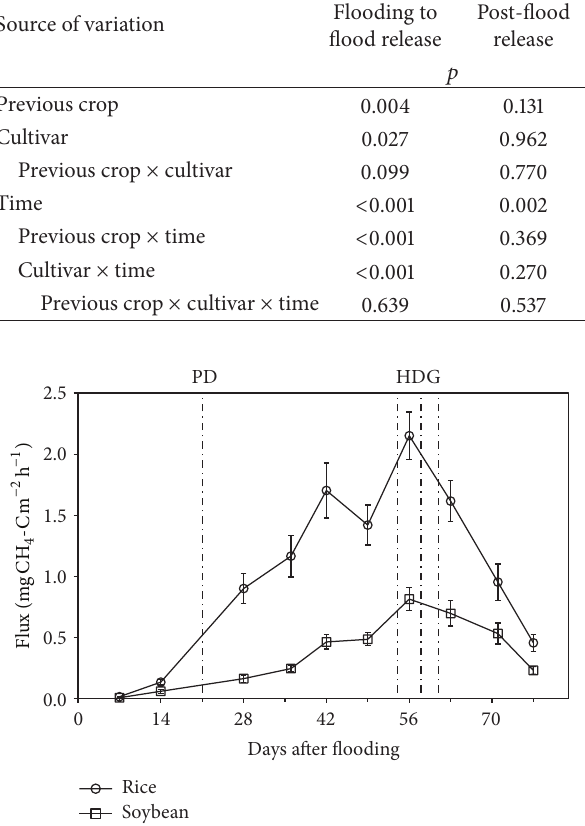
Figure 1: Methane fluxes over time throughout the flooded portion of the 2013 growing season from previous crop treatments averaged across cultivar at the Northeast Research and Extension Center in Keiser, Arkansas. The vertical dashed lines represent panicle differentiation (PD) and 50% heading (HDG) dates for CLXL745, Cheniere, and Taggart at 54, 58, and 61 days after flooding, respectively. Flood release occurred in 83 days after flooding. Least significant difference for the same previous crop treatment = 0.197 mg CH 4 -Cm −2 hr −1 and for different previous crop treatment = 0.309 mgCH 4 -Cm −2 hr −1 . Error bars indicate standard errors for the treatment means ( 𝑁 = 12 ).